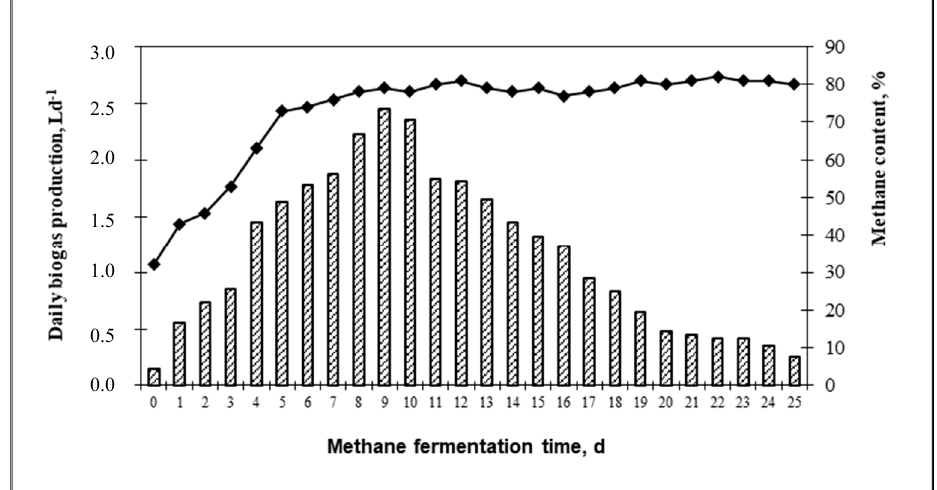
Figure 7. The biogas production process, including methane content, recorded in the process of anaerobic stabilization of disintegrated excess sludge with an ultrasonic field of intensity of 4.3 W cm − 2 .